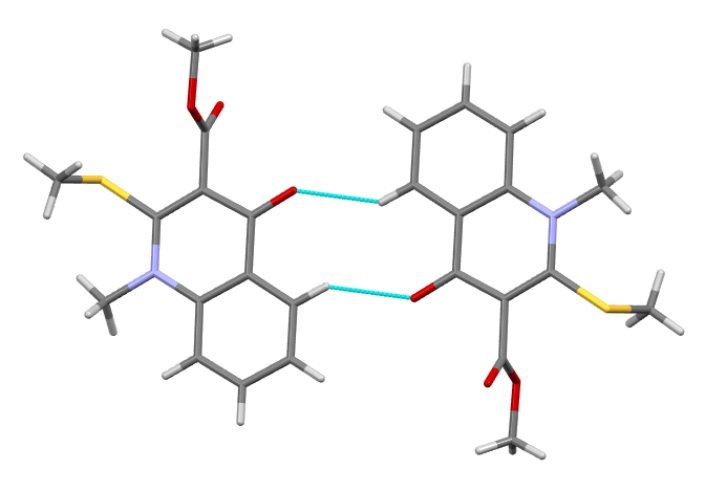
Figure 9. Centrosymmetric dimer of molecules 5 in the crystal phase. Hydrogen bonds are shown by dashed blue lines.